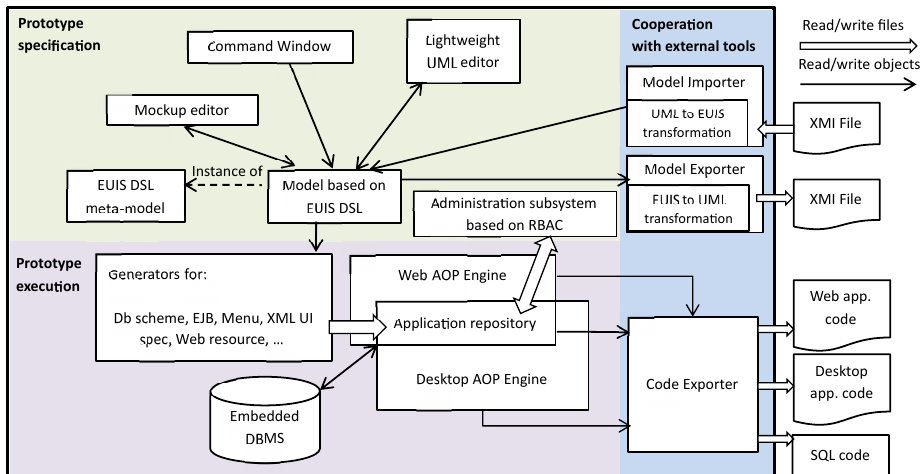
Figure 4. The architecture of